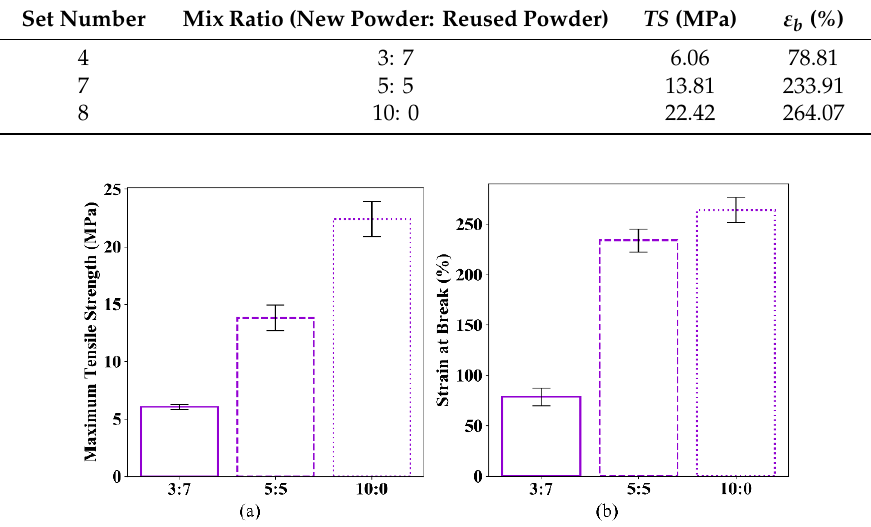
Figure 15. Comparison of ( a ) maximum tensile strength and ( b ) strain at break.